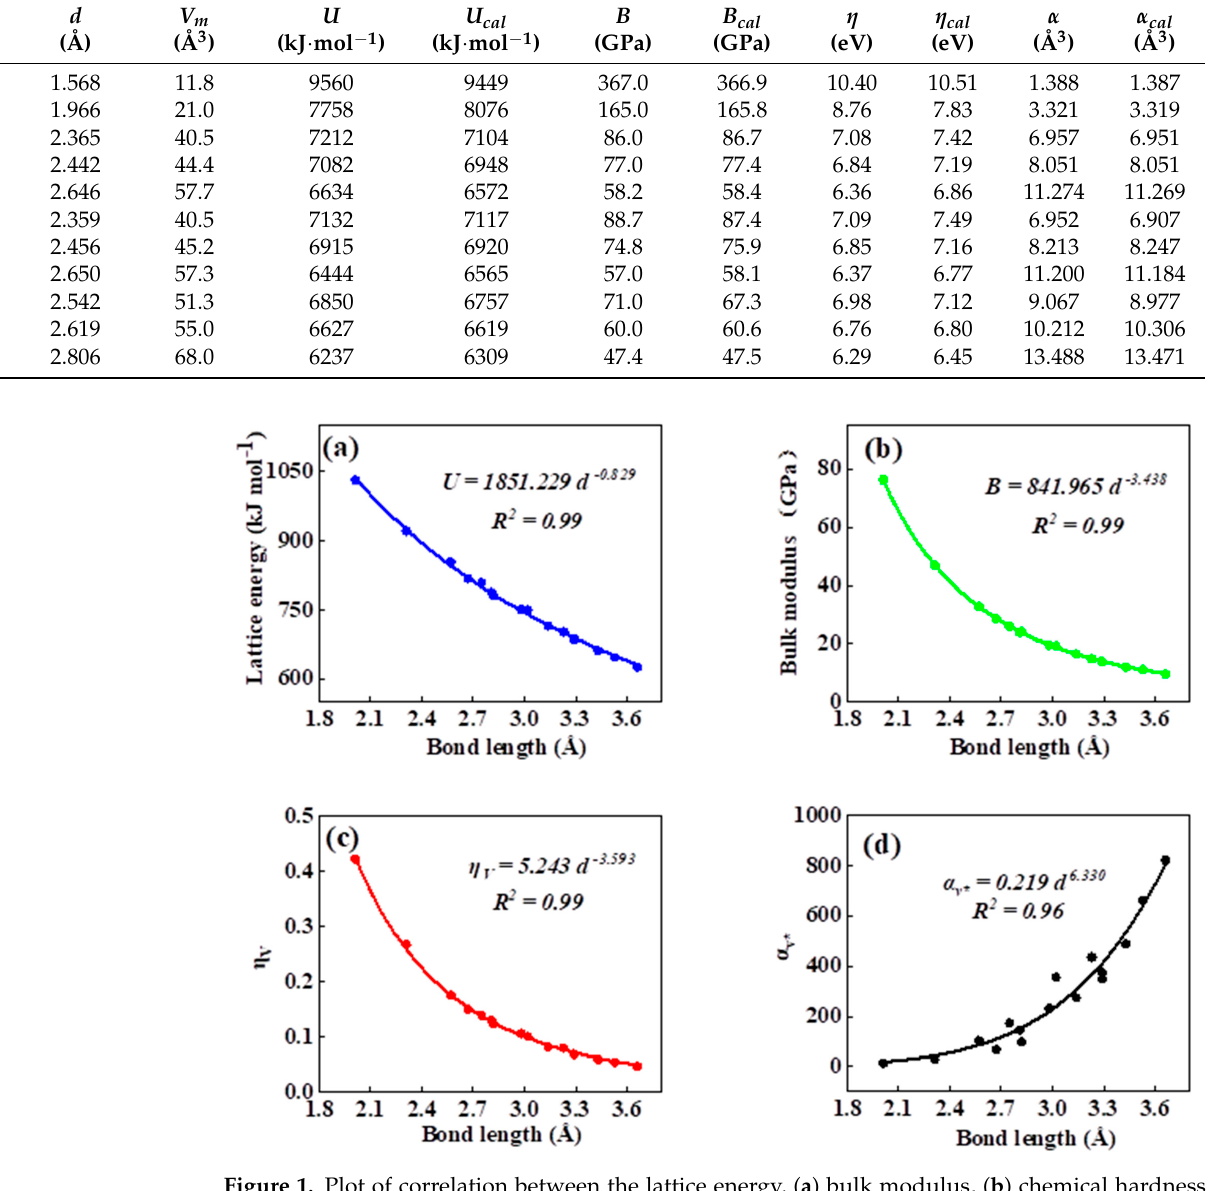
Figure 1. Plot of correlation between the lattice energy, ( a ) bulk modulus, ( b ) chemical hardness density, ( c ) product of electronic polarizability and molar volume, ( d ) and chemical bond length of rock salt crystals of group